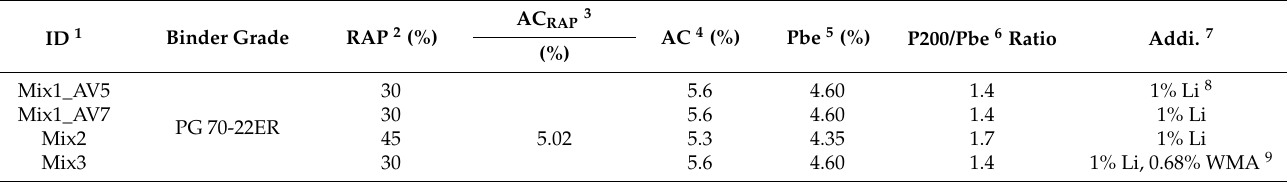
Table 1. Mix design and volumetric properties for the three trial